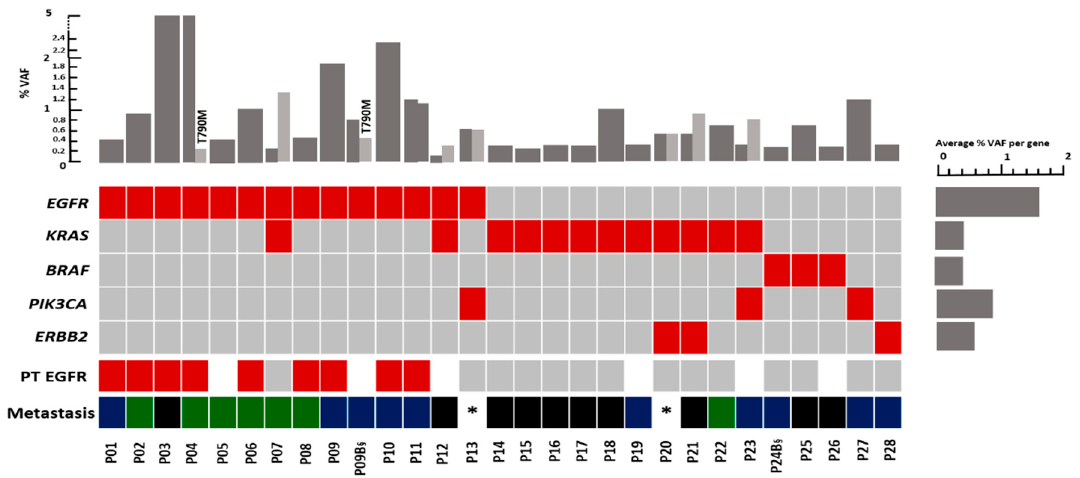
Figure 2. Overview of mutations detected (lower panel) and their variant allele frequency (VAF) (upper panel) in advanced NSCLC patients using the MassARRAY system. When double mutants are detected in one patient, the order of VAF bars are shown in the order of genes in the plot.